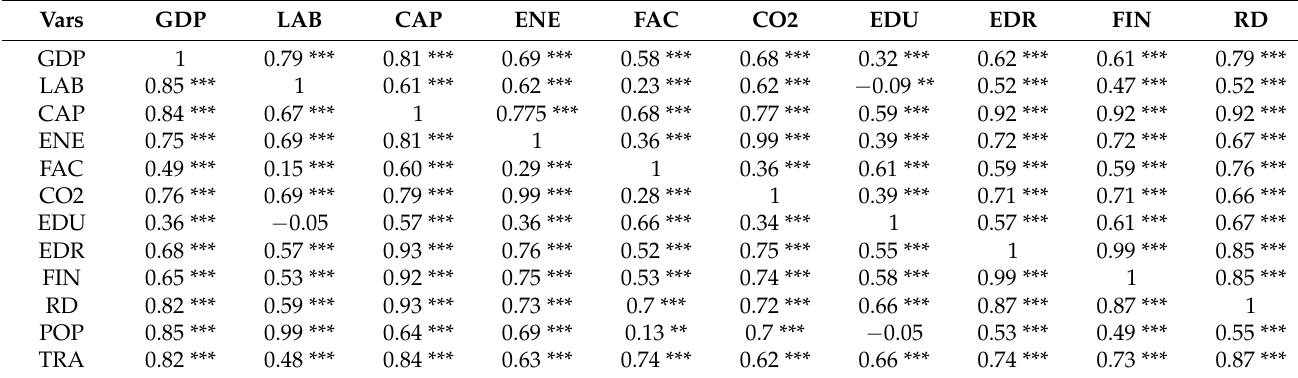
Table 2. Summary of correlation coefficients between